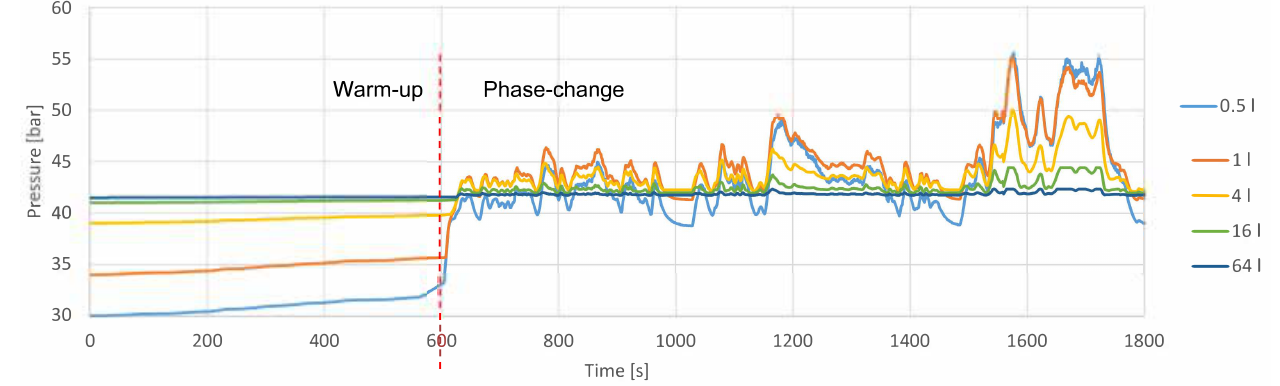
Figure 10. Predicted pressure evolution inside the VC TS along the WLTC type 3 driving cycle, for several expansion tank volumes. For each condition, initial (pre-charge) pressure was adjusted for a 250 ◦ C hot face